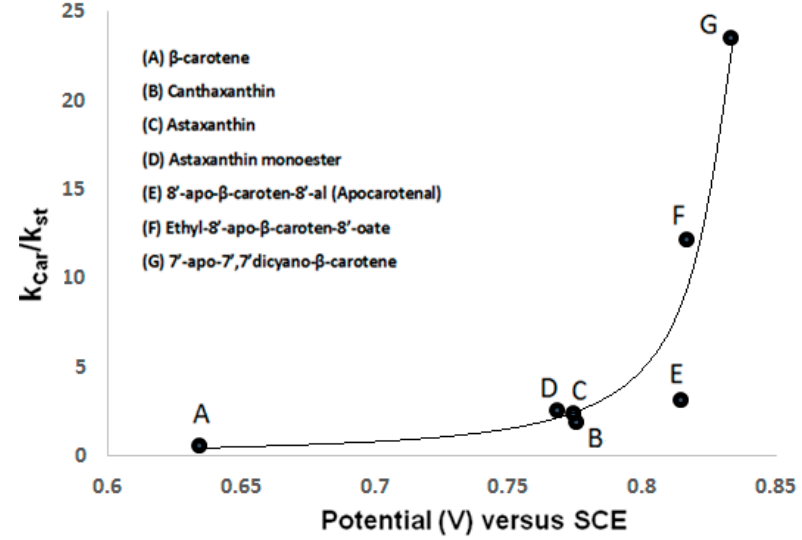
Figure 2. Plot of first oxidation potential versus scavenging ability (K car /K st ) of carotenoids A–G. K car reflects all possible ways of radical interaction with carotenoids and K st is the relative spin trapping rate.